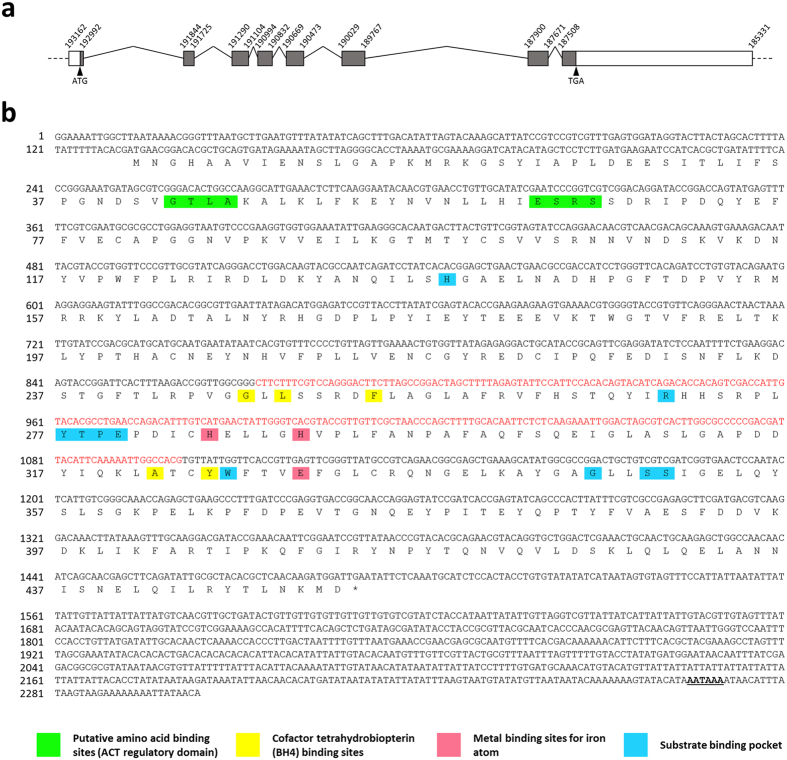
Characterization of the ApPAH gene.(a) Schematic overview of ApPAH gene structure. Exons, 5′ and 3′ untranslated region (UTR), and introns are represented with grey boxes, white boxes, and solid lines, respectively. Arrowheads indicate the translation start site (ATG) and stop codon (TGA). Genomic coordinates refer to the positions on the scaffold GL350506 available from AphidBase38. (b) Nucleotide and amino acid sequences of the ApPAH gene. ApPAH comprises a 1,359 bp CDS encoding 452 amino acid residues, indicated as single-letters above the nucleotide sequence. Conserved binding domains are highlighted in different colors. The stop codon is marked with an asterisk. Underlined bold letters and red letters indicate the polyadenylation signal (AATAAA) and the sequence targeted by the dsApPAH, respectively.